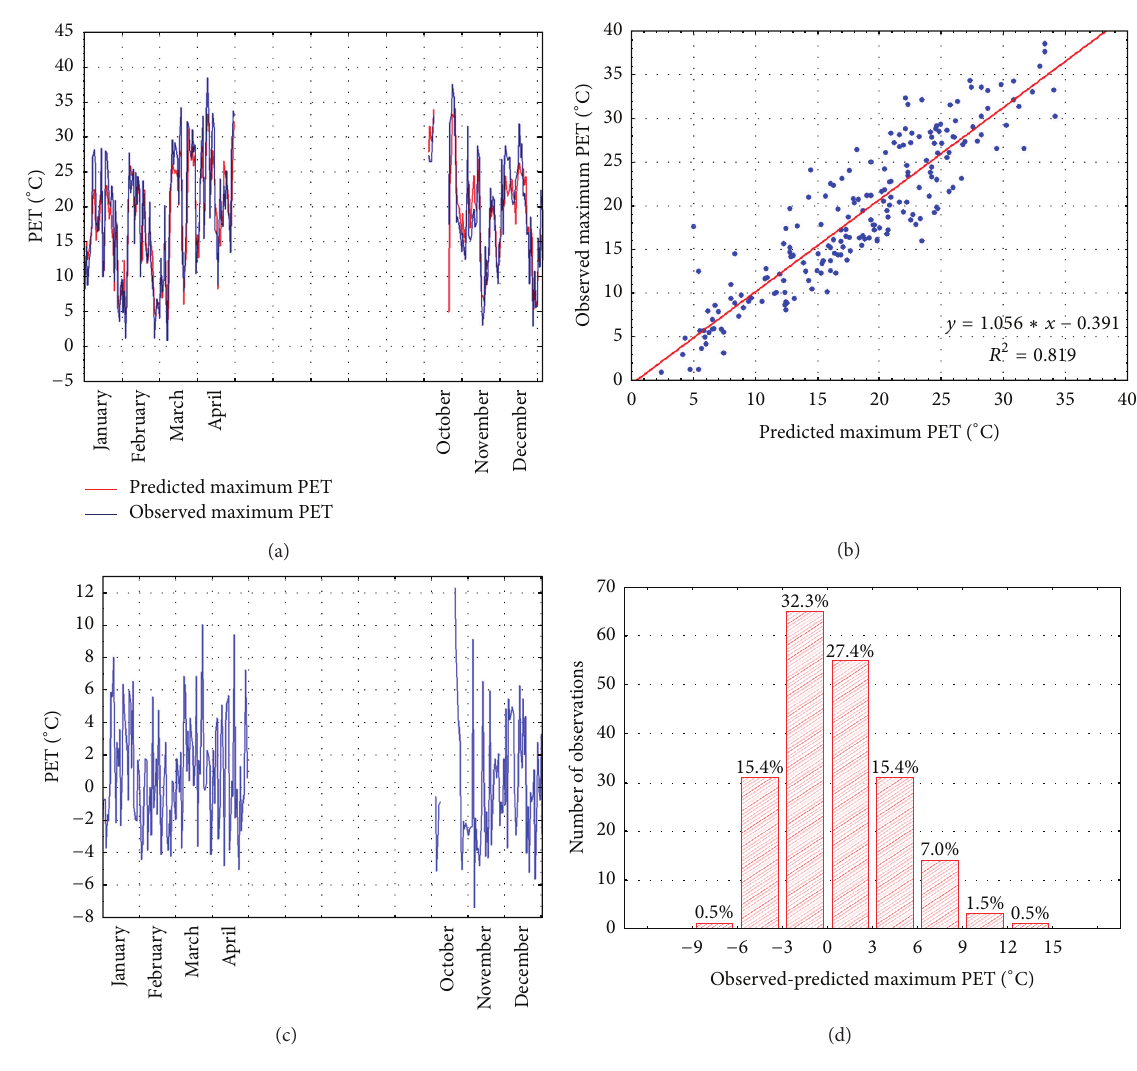
Figure 9: Observed versus predicted daily maximum PET values (a); scatter plot between observed versus predicted daily maximum PET values (b); observed minus predicted daily maximum PET values (c) and histogram with the absolute differences between the observed and the predicted daily maximum PET values (d). One day ahead prognosis. Cold period of